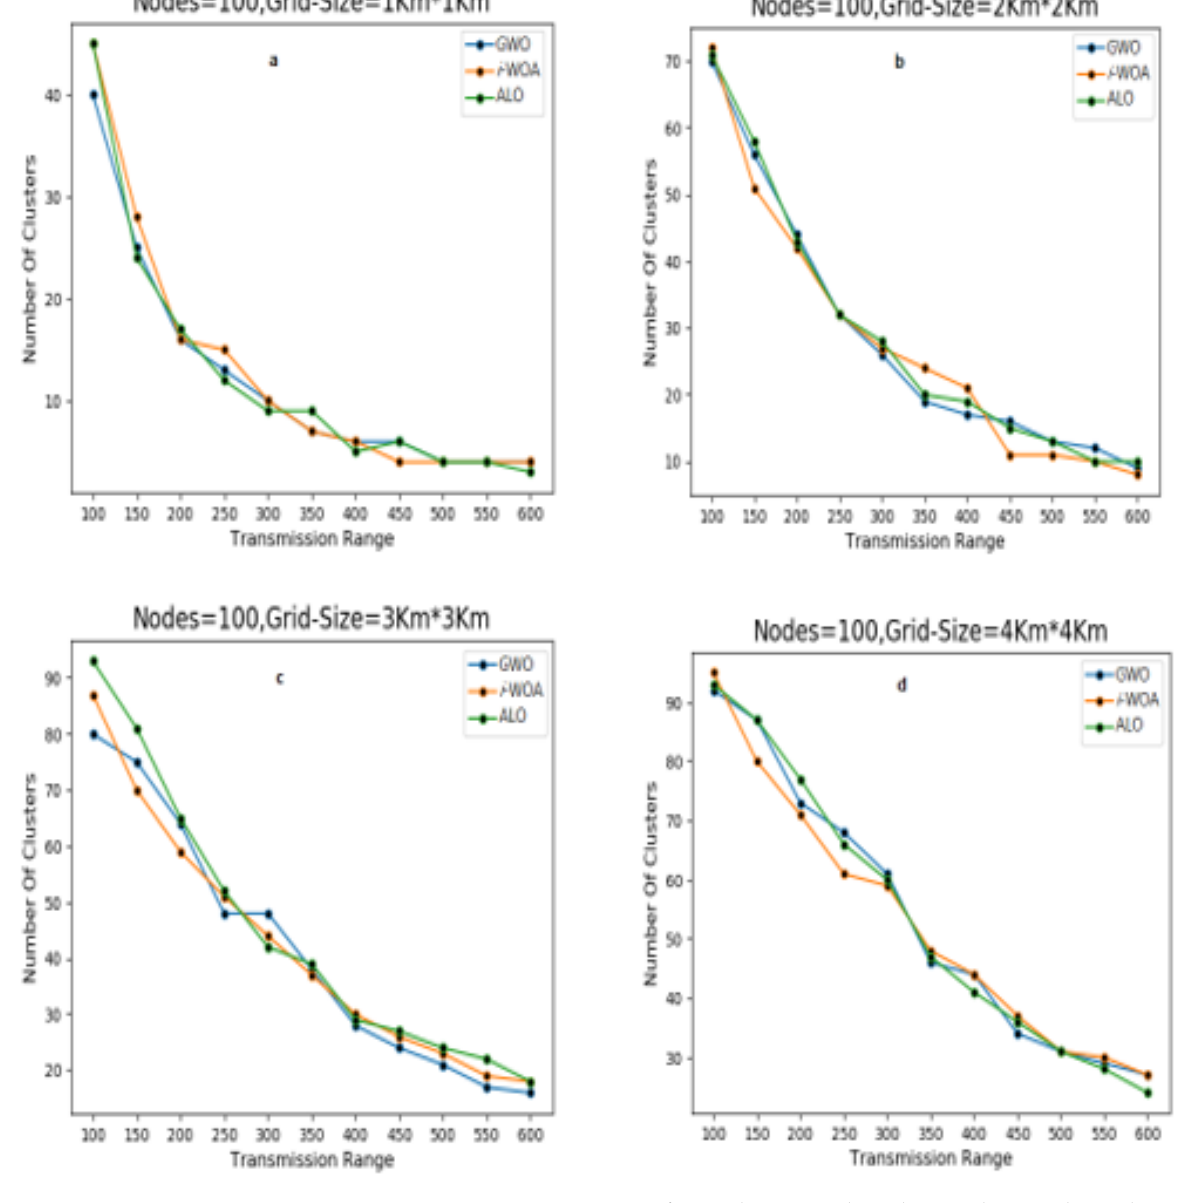
Figure 4. Transmission range vs. CHs for Nodes 100 and Grid Size 1 km × 1 km, 2 km × 2 km, 3 km × 3 km, and 4 km × 4 km. ( a ) Nodes = 100, Grid-Size = 1 km × 1 km; ( b ) Nodes = 100, Grid-Size = 2 km × 2 km; ( c ) Nodes = 100, Grid-Size = 3 km × 3 km; ( d ) Nodes = 100, Grid-Size = 4 km × 4